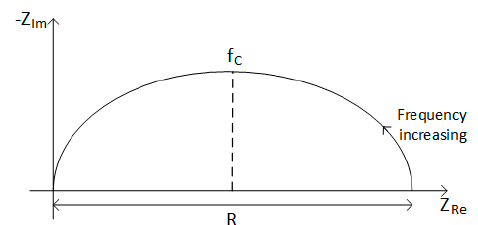
Figure 10. Nyquist plot of the ideal semi-circular response from a RC circuit.